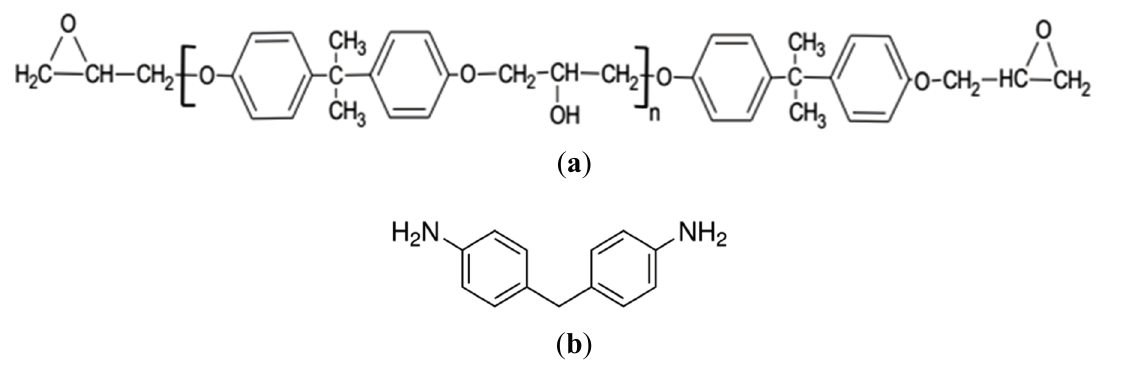
Figure 3. Chemical structures of ( a ) Diglycidyl Ether of Bisphenol-A (DGEBA), and ( b ) 4, 4’ Diamine-Diphenylmetane (DDM).